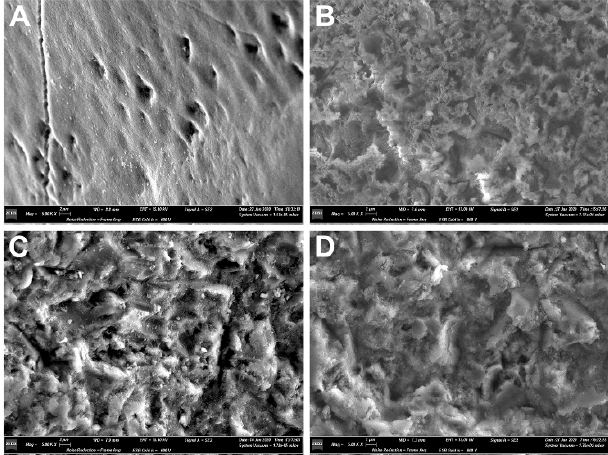
Figure 5. Scanning electron microscope (SEM) imaging of the teeth after application of different enamel conditioning treatments. Images were taken at 5000× magnification under SE modality at high tension (15.0 kV). ( A ) normal and intact enamel; ( B ) acid etching (E group); ( C ) hydroabrasion (HA group); ( D ) acid etching and hydroabrasion (HA-E group).